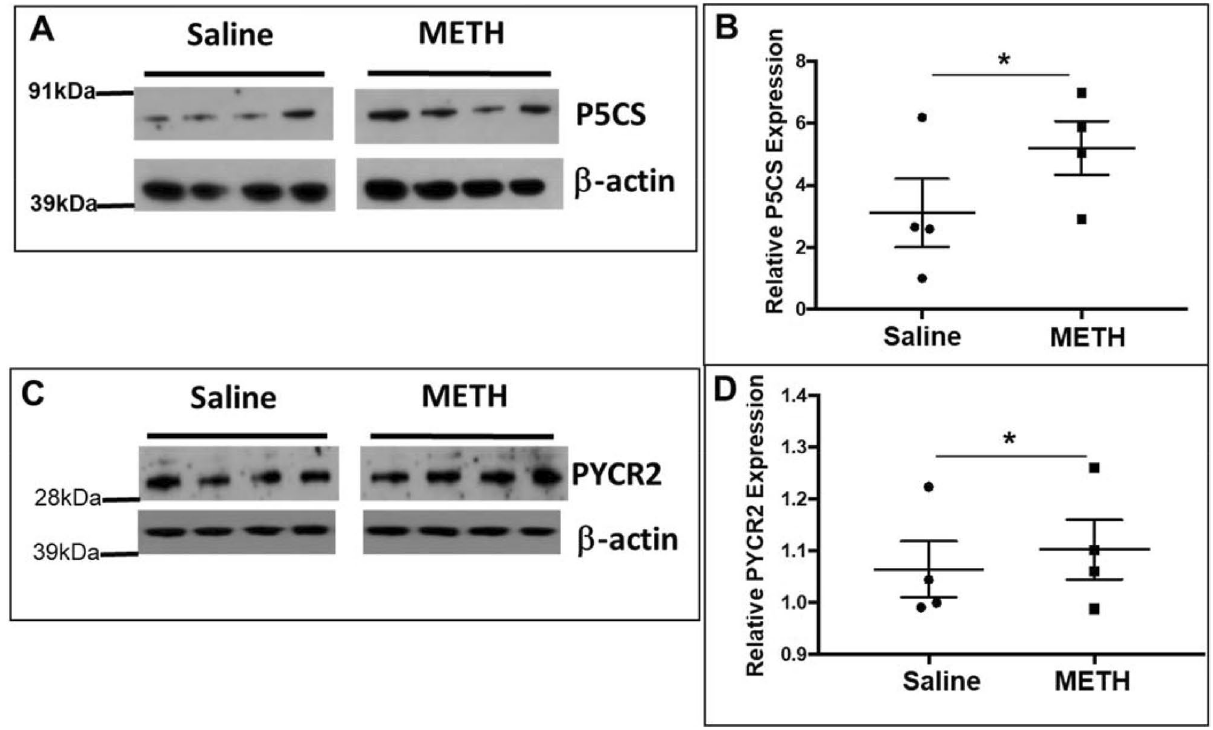
Figure 6. METH treatment activates proline synthetic pathway in cortical regions of mice brain-Mice were injected intra-peritoneally (IP) with a single dose of METH (2 mg/kg) for acute METH treatment. Then the animals were euthanized after 24 h and whole brain was isolated from METH treated (n = 4) and saline-treated (n = 4) animals. Cortical regions were then sliced and homogenized for measuring the levels of proline synthetic enzymes. ( A ) Representative western blot probing P5CS levels in the cortices of saline treated mice and METH treated mice with β-actin used as a loading control (n = 3). ( B ) Quantitative representation of P5CS western blot of either saline or METH treated mice. ( C ) Western blot probing for PYCR2 in the cortical region of saline treated mice and METH treated mice with β-actin used as a loading control (n = 3). ( D ), Quantitative representation of PYCR2 western blot of either saline or METH treated mice. Data are presented as the mean ± SEM of at least three independent experiments. *p < 0.05 represents statistical comparison of untreated vs METH-treated